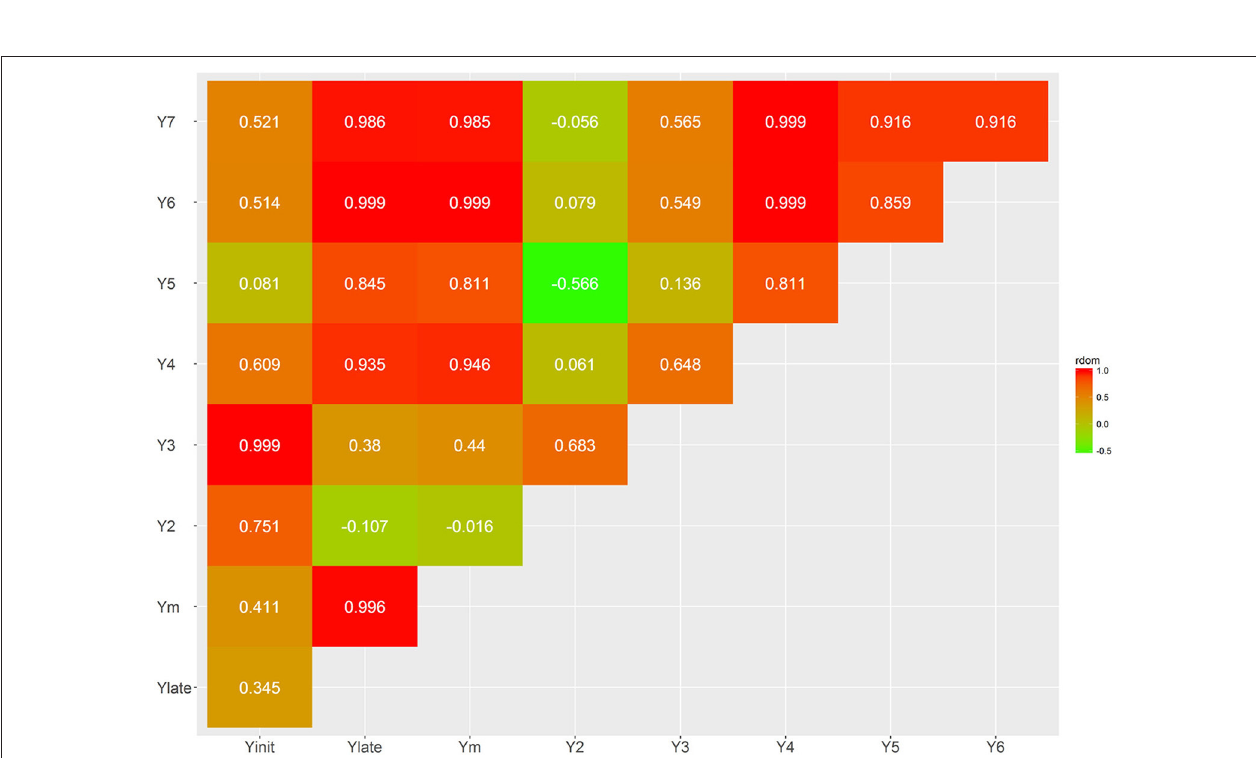
FIGURE 6 | Genetic trait correlations for dominance effects: all yield derived traits.